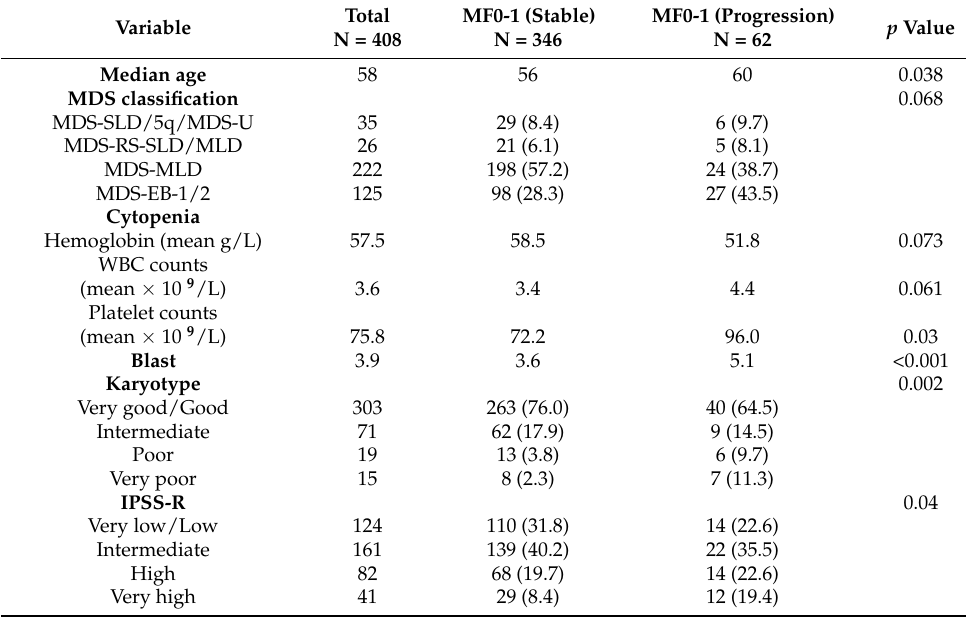
Table 3. The characteristics of patients with progressed MF.